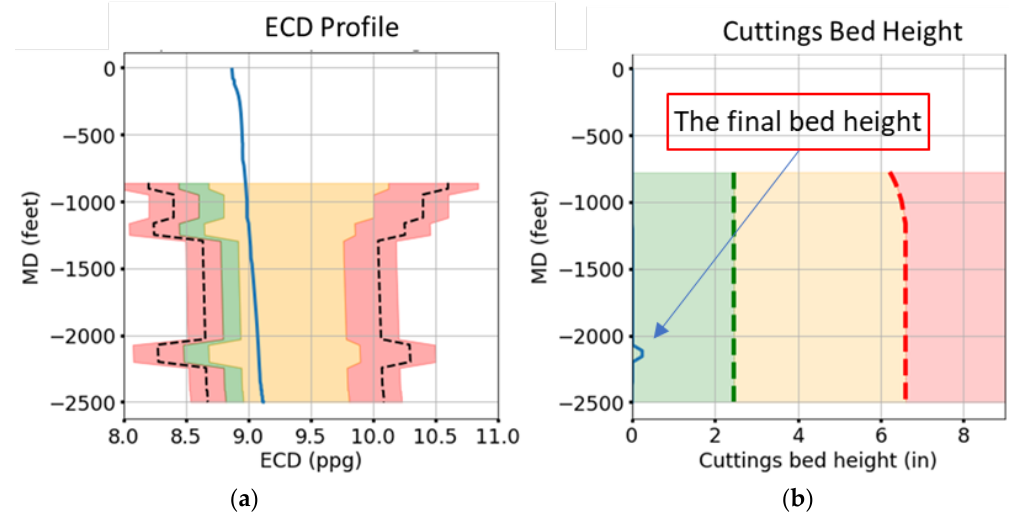
Figure 20. ( a ) ECD profile ( b ) Cuttings bed height (output state) for 𝑎 𝑠𝑒𝑞1 .